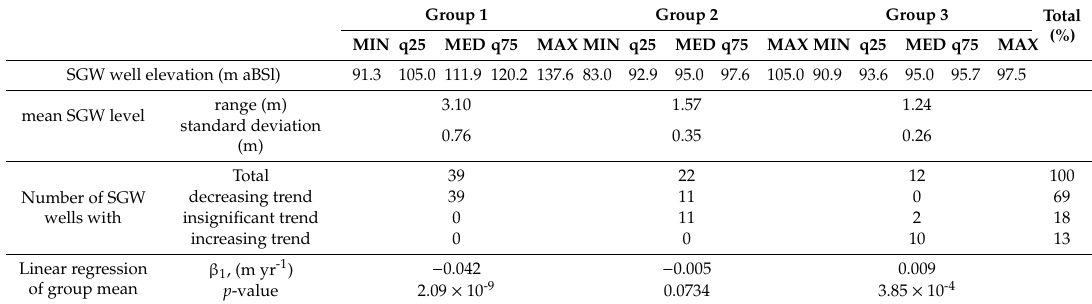
Table 1. Descriptive statistics of the cluster groups of the SGW wells. The first row represents the statistics related to the elevation of the SGW wells in a particular group, while the other rows are related to the SGW levels of the SGW wells in a particular